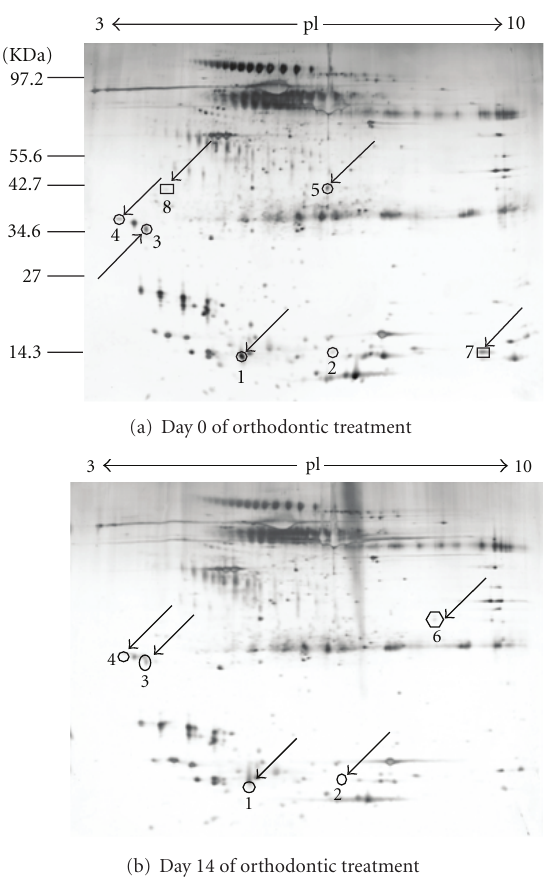
Figure 1: Representative 2DE gels of human saliva proteome. Saliva proteins resolved by 2-DE (pI 3-10, 24cm). The resulting gels were visualized by silver staining. Arrows indicate protein spots that changed in expression during orthodontic treatment. The numbers correspond to proteins in Table